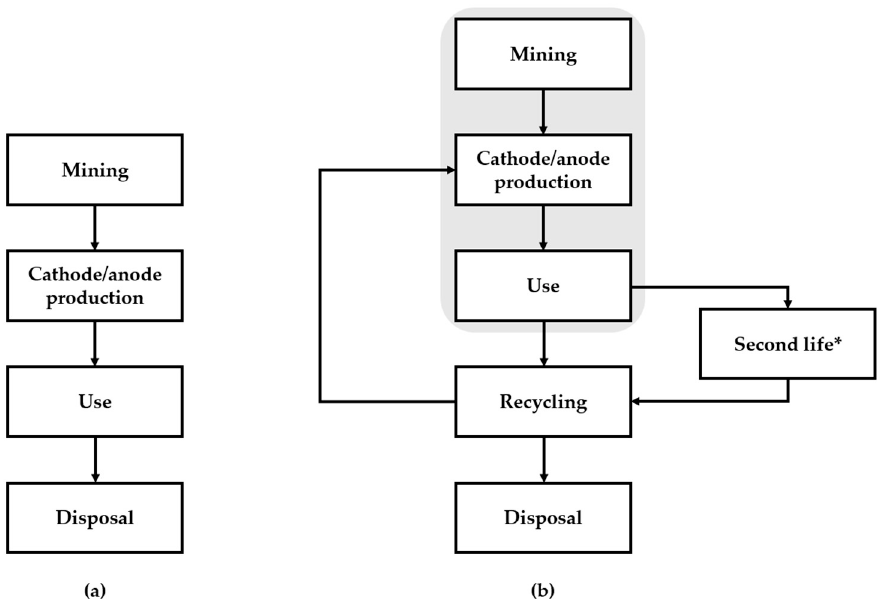
Figure 1. LIB life cycle: ( a ) actual ( b ) proposed. Adapted from [29]. * Second life depends on the cathode’s chemistry and the recycling industry’s location. For example, in some places in China, the second life of NMC batteries will be banned.